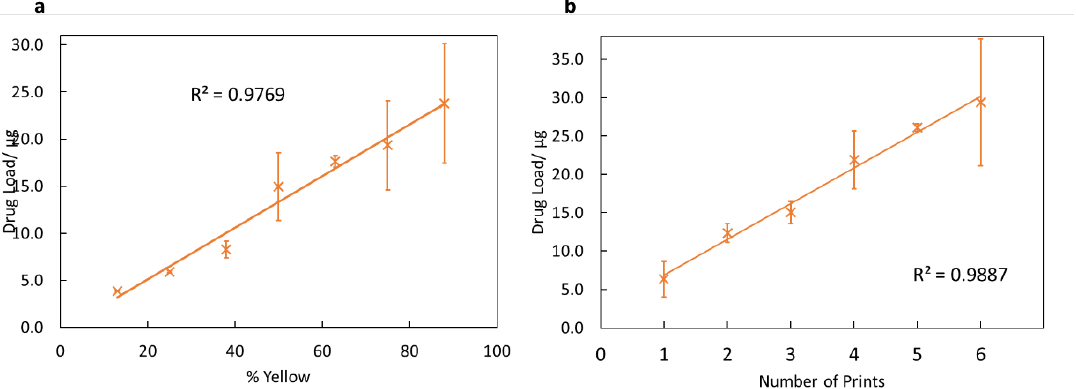
Figure 5. Plots demonstrating methods for controlling the drug dose applied. ( a ) A graph showing the results for how the drug load changes with the changing percentage of yellow of the object. The percentage of yellow corresponds with the lightness of the yellow. Error bars show the standard deviations. ( b ) A graph showing how the number of times printing was conducted affects the total drug load. Error bars show the standard deviations.